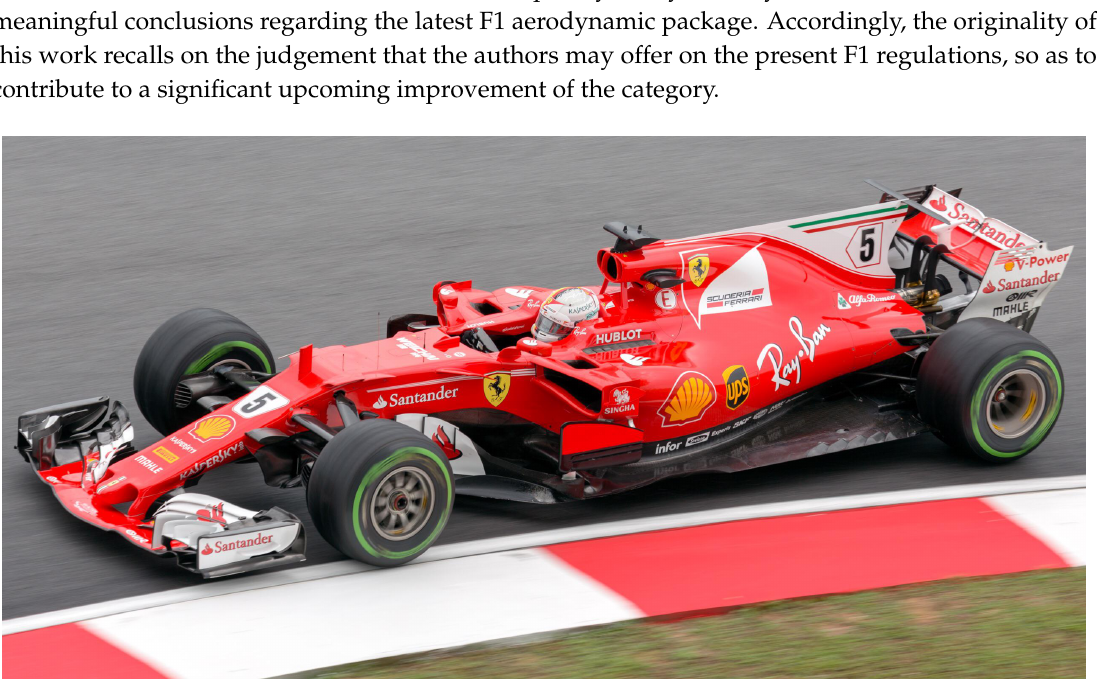
Figure 1. Ferrari SF70H, a 2017 spec. car. Extracted from Reddit